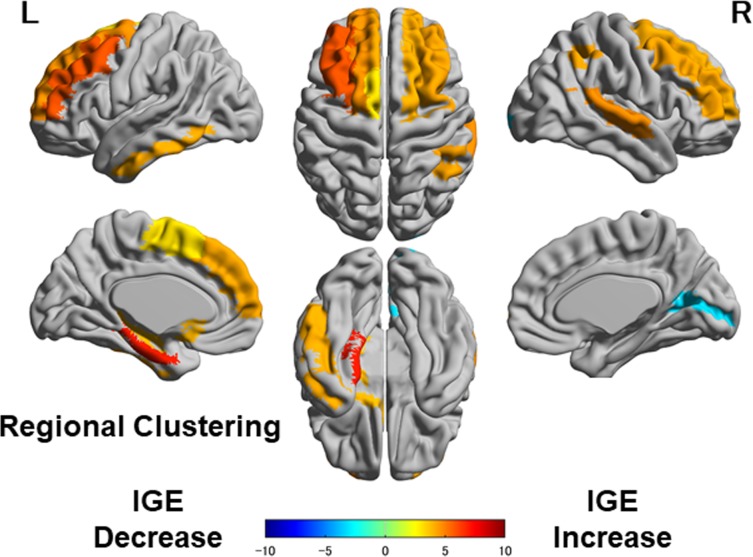
Regional comparisons of clustering between the control and IGE groups.Colored areas indicate significant differences.